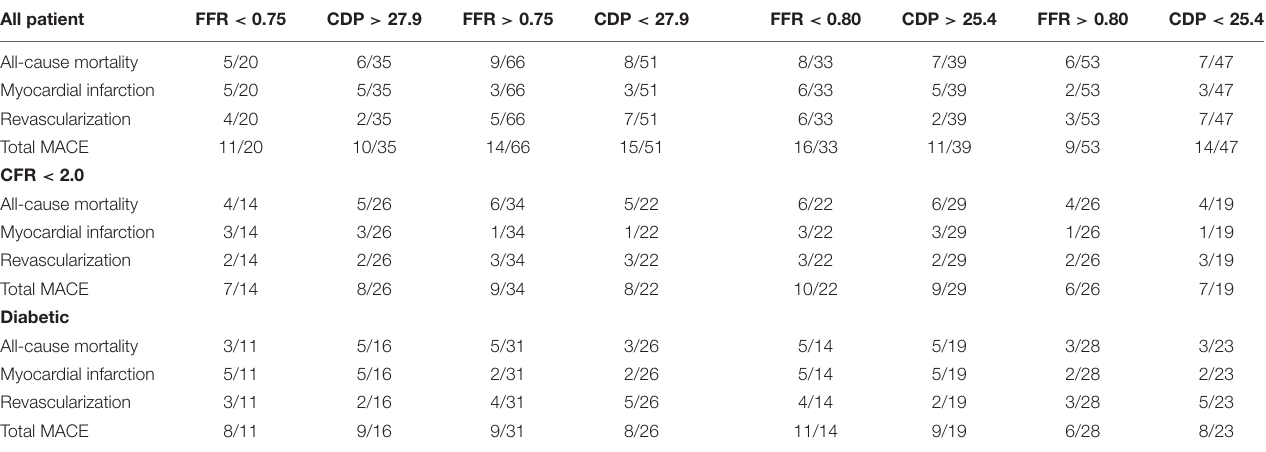
TABLE 2 | Summary of the %MACE outcomes for the recruited patients at 5-year follow-up. All patient FFR < 0.75 CDP > 27.9 FFR > 0.75 CDP < 27.9 FFR < 0.80 CDP >